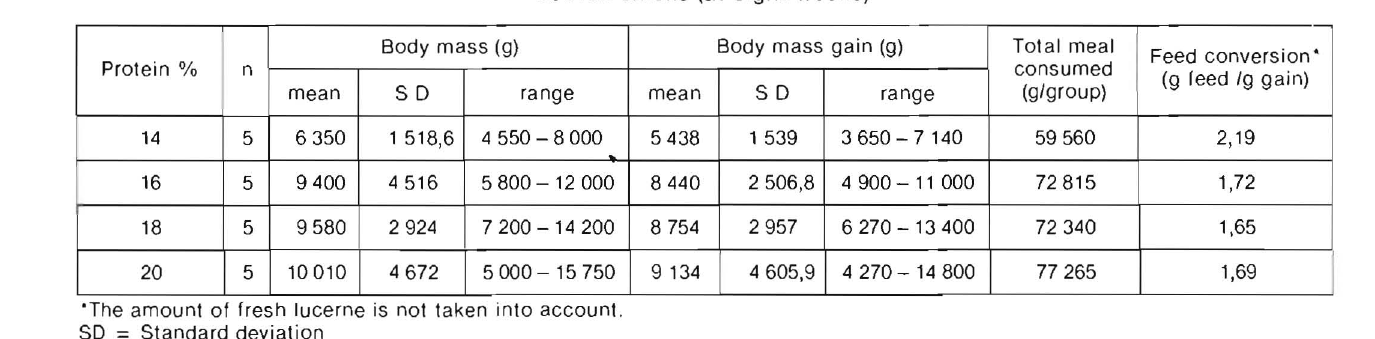
Table 2: Effect of feeding different dietary protein levels on growth, feed consumption and feed utilization of ostrich chicks (at eight weeks)